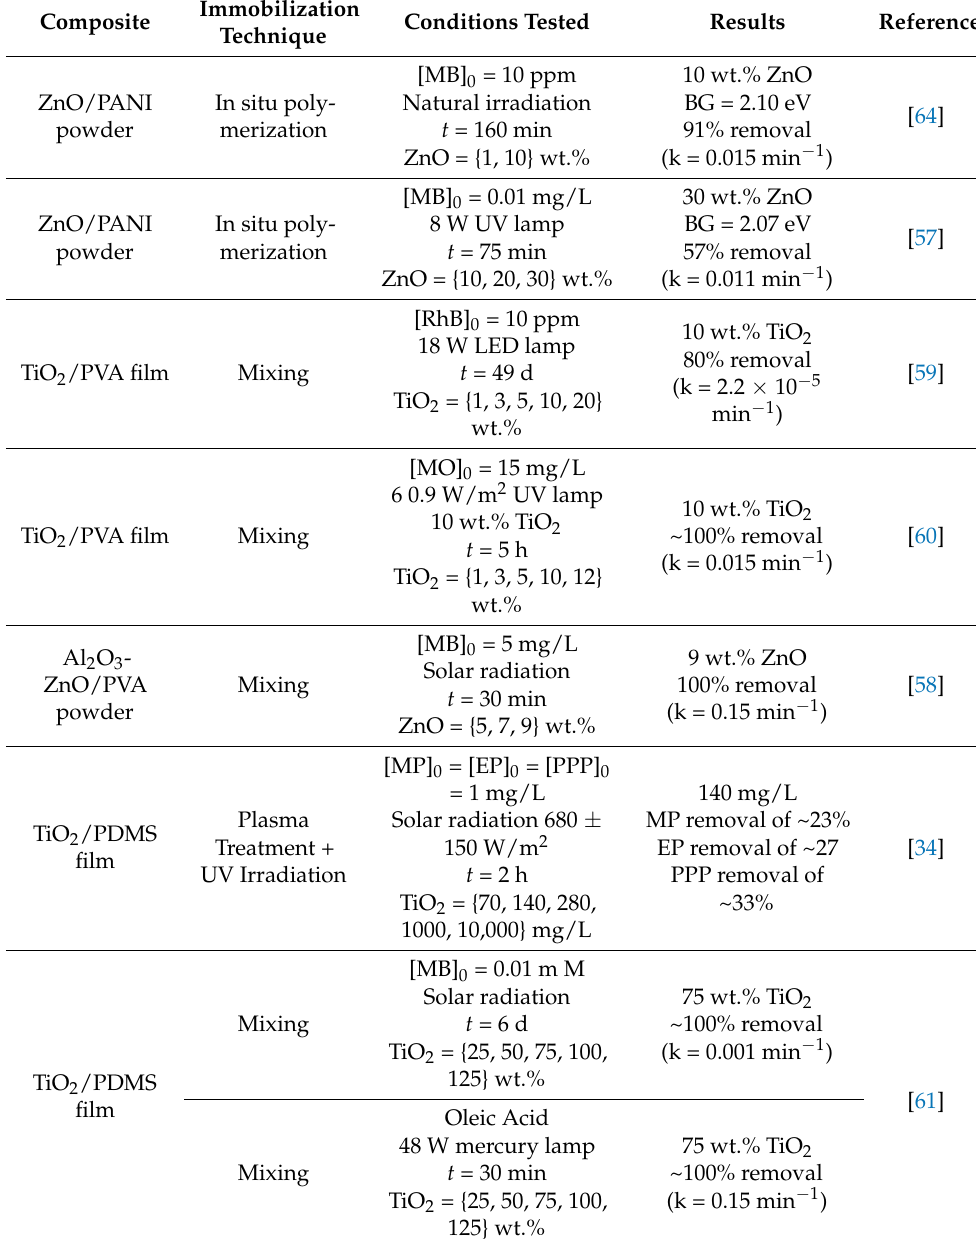
Table 2. Summary of studies that have analyzed the effect of the photocatalyst dosage on the polymer-supported photocatalysis